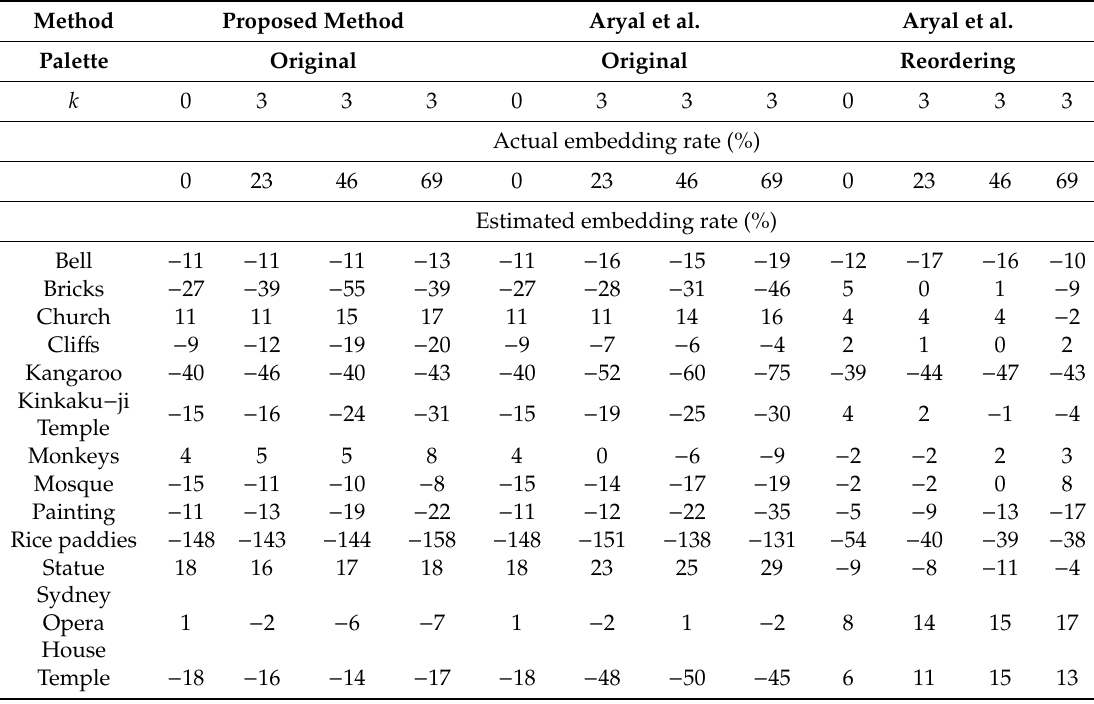
Table 7. The results of RS steganalysis for Aryal et al.’s [17] and the proposed methods with block size 1 × 3.